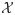
a) Kernel PCA deduces an implicit transformation Φ from input space X (green circles) into a high-dimensional feature space where linear algorithms can be employed to separate image data from artifacts (red circles). b) Denoising is performed by projecting the test vector x onto the first q principal components by Pq. Backmapping of the projected data is done by finding a so-called pre-image z in image space which minimizes the Euclidean distance between Φ(z) and PqΦ(x).